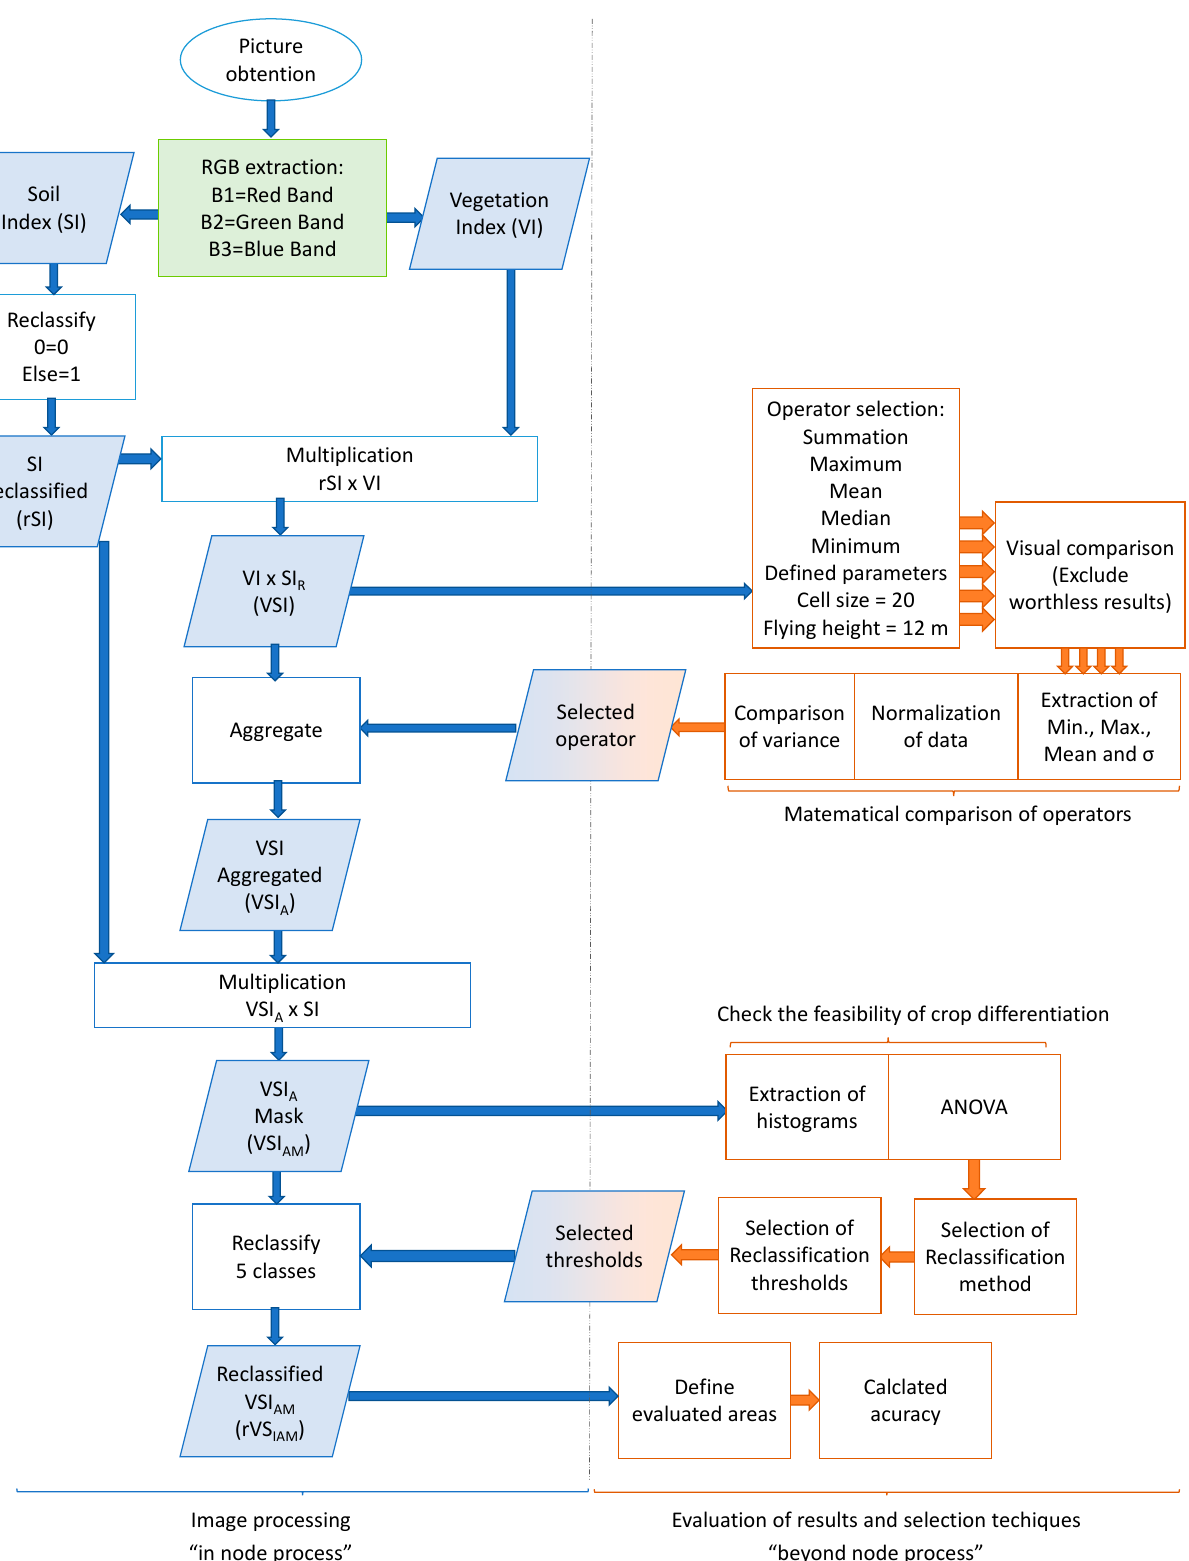
Figure 3. Summary of followed processes presented as a flow chart.